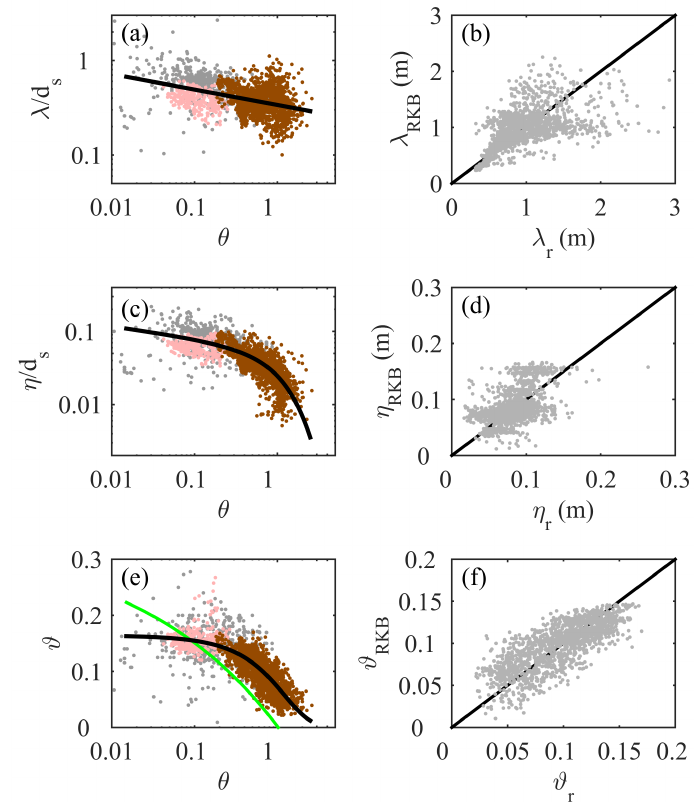
Figure 13. Measured ( a ) normalized ripple length λ/d and ( e ) ripple steepness ϑ versus the Shields parameter θ . Brown dots: Bardex II data; grey dots: Goldstein et al. [6]; light-red dots: Masselink et al. [7]. The black lines are our least-squares fits based on all data. The green line in ( e ) is based on Nielsen [48]. Panels ( b ), ( d ) and ( f ) are scatter plots of predicted versus measured ripple parameters (Bardex II data only) together with the 1:1